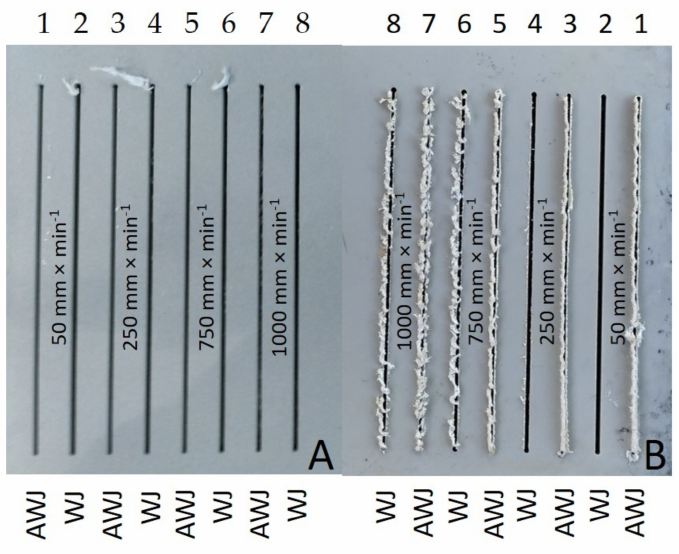
Figure 14. Cutting gaps in PP + POLURAN: ( A ) WJ and AWJ inlet; ( B ) WJ and AWJ